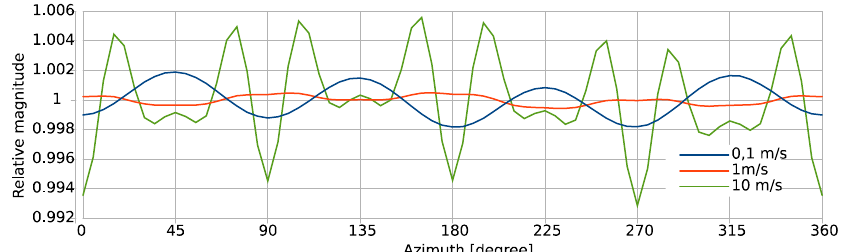
Figure 11. Relative magnitude variation of the voltage vectors generated by the “wide” thermistor bridge arrangement and mean flow velocities of 0.1, 1, and 10 m / s in the flow compartment of the finite element (FE) model.